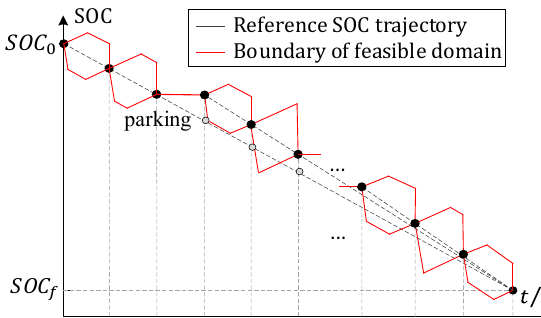
optimal 𝑆𝑂𝐶 trajectory obtained by the DP strategy declines linearly as a whole.